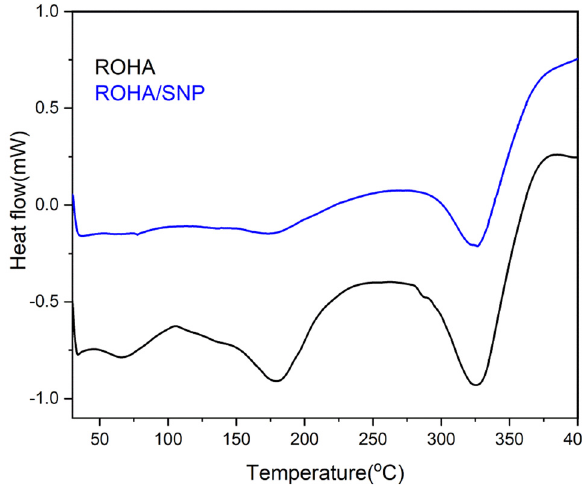
Figure 10: DSC thermogram of ROHA and ROHA/SNP nanocomposite.